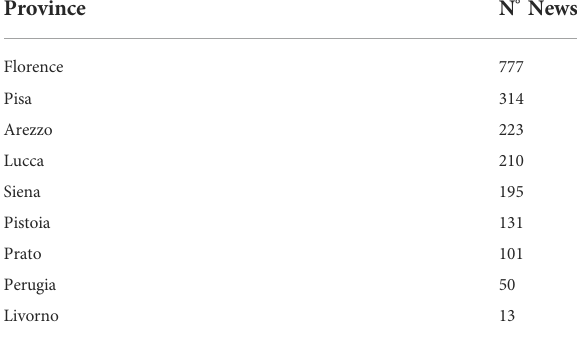
TABLE 2 Amount of landslide online news for each